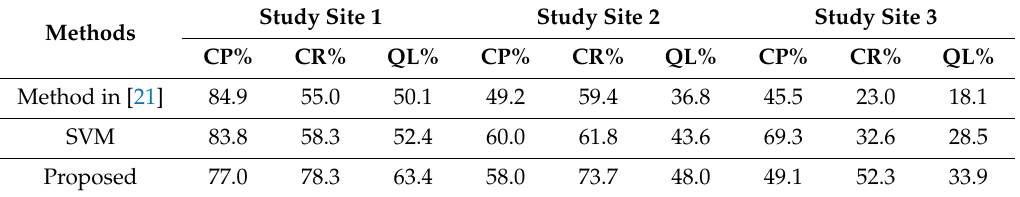
Table 3. Quantitative indexes of the extracted results in test sites with different segmentation methods.